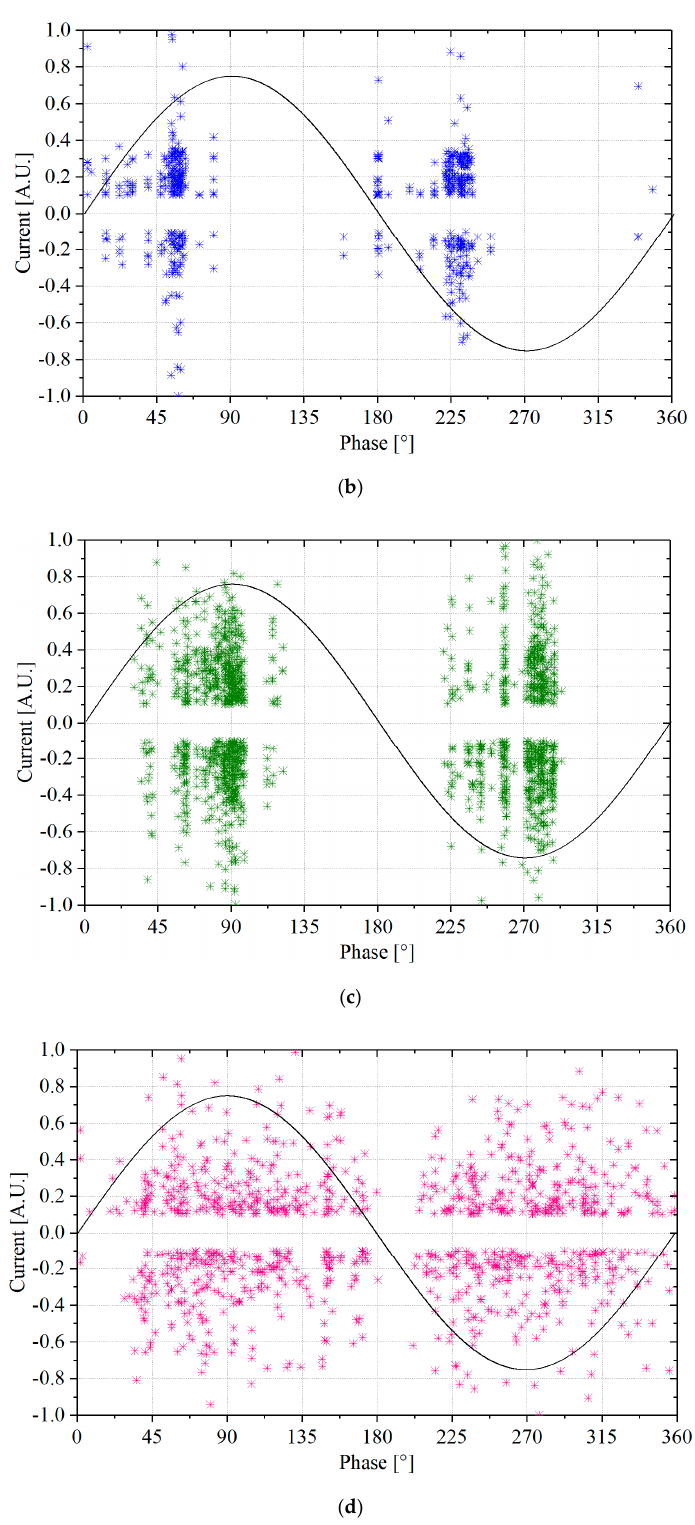
Figure 7. PRSA patterns depending on loads. ( a ) Electric heater; ( b ) PC; ( c ) refrigerator; ( d ) air conditioner.